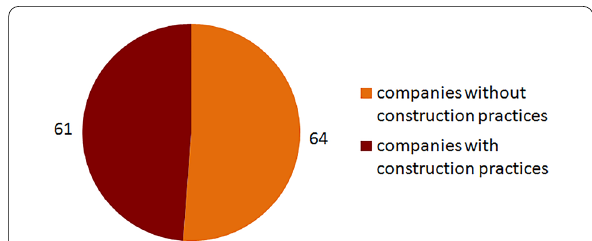
Fig. 5 Number of companies that have or have not used DRs in